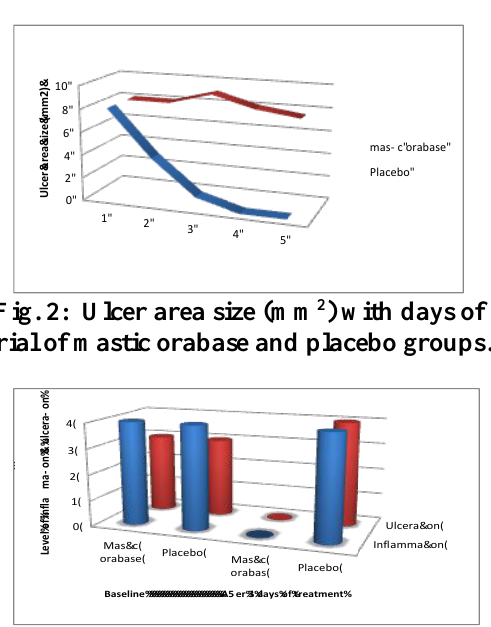
Fig. 3: Level of inflammation and ulceration at baseline and after 3 days of treatment in both